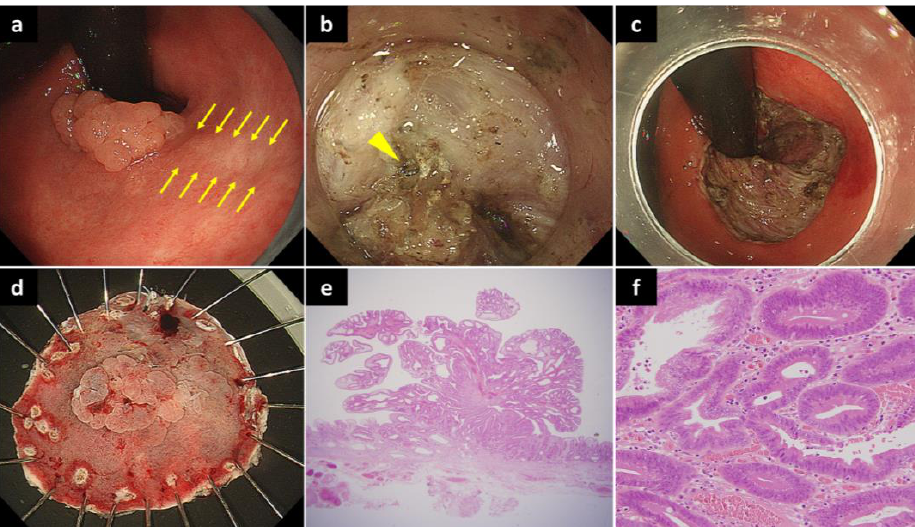
Figure 1. A lesion on the suture line: ( a ) An elevated gastric cancer has been observed on the suture line (between yellow arrows) in the lesser curvature of the remnant stomach. ( b ) During ESD, staples (yellow arrowhead) and massive fibrosis are present at the suture line. ( c ) The lesion is completely removed by ESD without perforation. ( d ) The resected specimen immediately after ESD. ( e ) Histological finding of the resected specimen reveals an intramucosal tubular adenocarcinoma with negative margins (HE staining). ( f ) Clusters of cancer cells forming glandular ducts were observed (HE staining). ESD, endoscopic submucosal dissection; HE, hematoxylin and eosin.